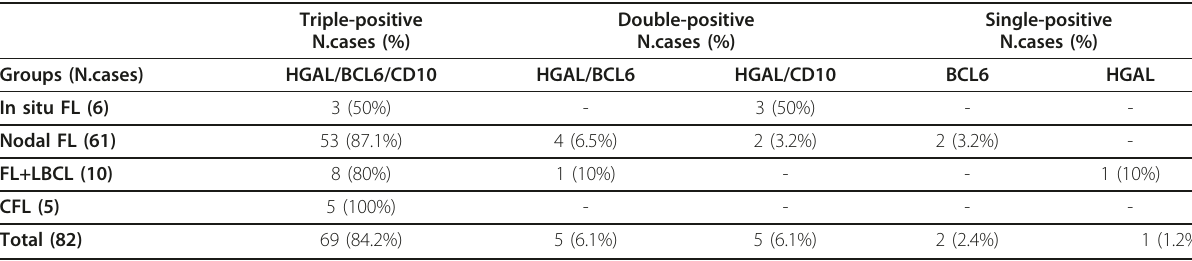
Table 2 Combination of GC-marker immunoreactivity in the series of FL Triple-positive N.cases (%)